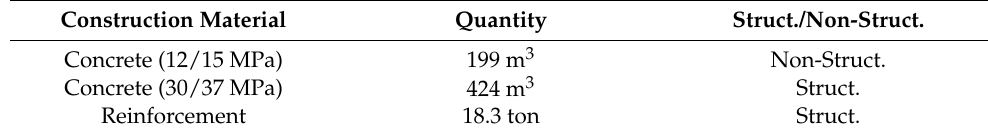
Table 3. Bill of materials: foundation.